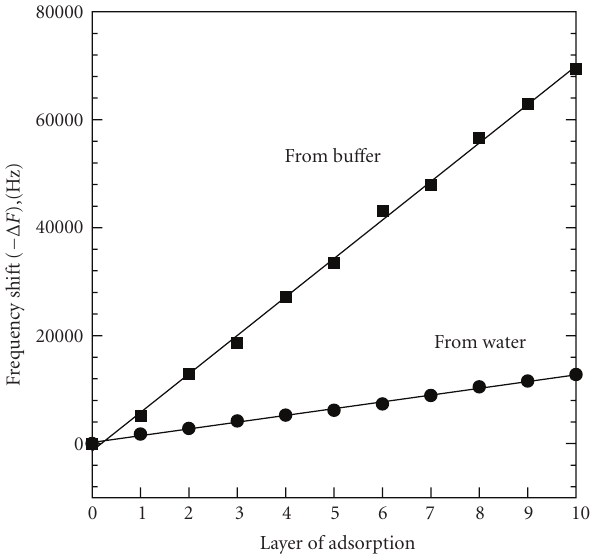
Figure 1: QCM resonator frequency shifts upon deposition of each layer of PDMS-1 (odd numbers) and PDMS-2 (even numbers) prepared from water and bu ff er solutions.